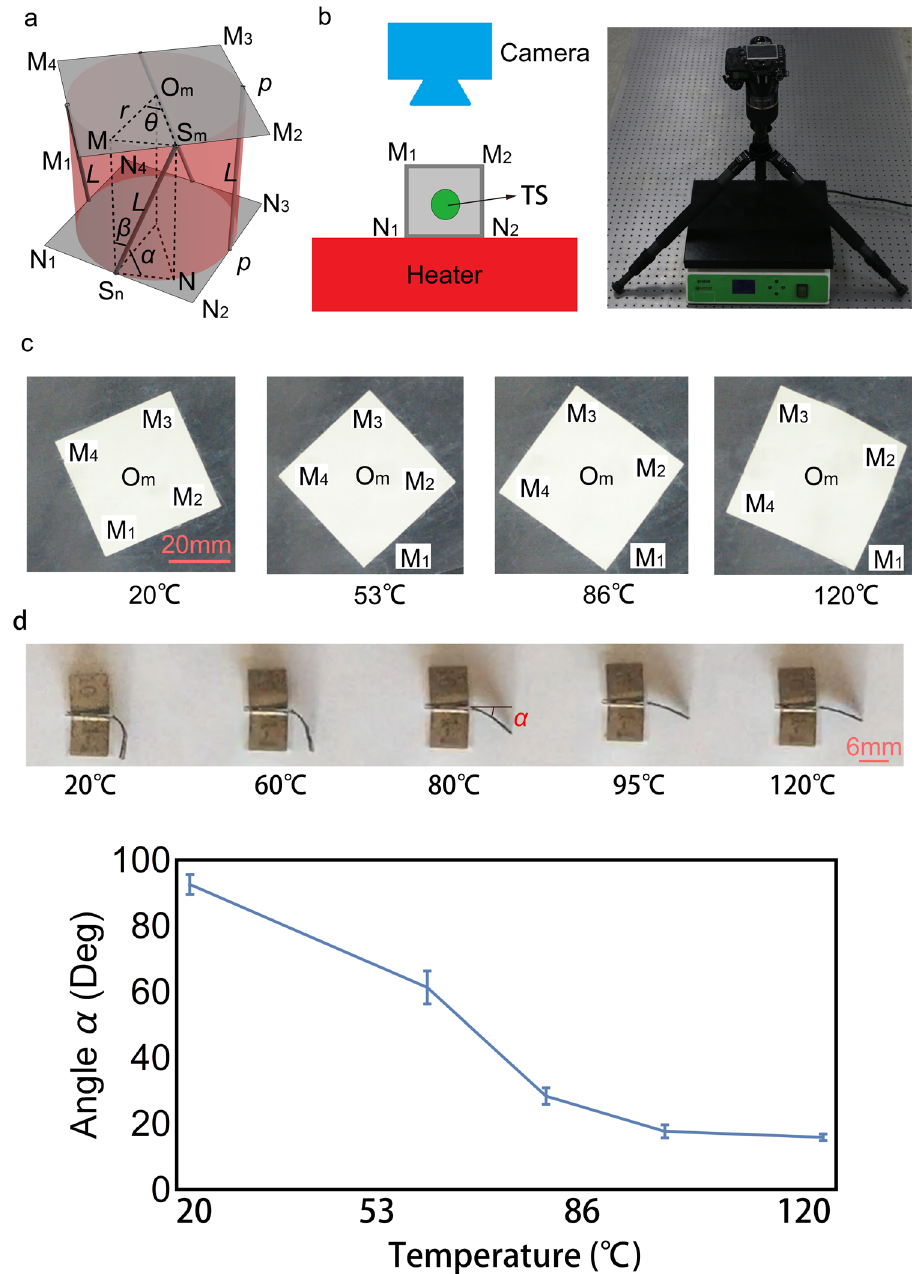
Figure 1: ( a ) Geometrical model of the motor with four spokes. ( b ) Experimental scheme and photograph of the experimental setup. ( c ) Photographs of the motor ’ s upper surface captured at four instantaneous moments. ( d ) Photographs of a TiNi SMA sheet with one side fi xed during heating. Half of the TiNi SMA sheet is fi xed between two “ V ” - shaped steel sheets, and another half is free. The plot shows angle α as a function of temperature. The error bars are based on four SMA sheets. Each SMA sheet was measured three